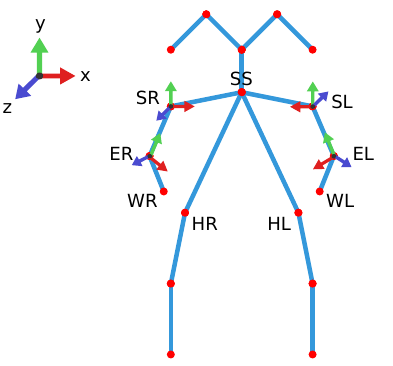
Figure A1. Coordinate systems of the thorax and the humerus